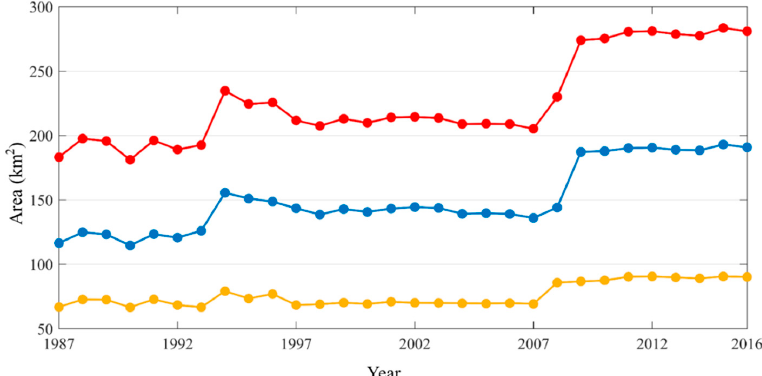
Figure 6. Annual variations in the areas of Changxing Island (blue line), Hengsha Island (yellow line), and the total combined island area (red line) from 1987 to 2016.